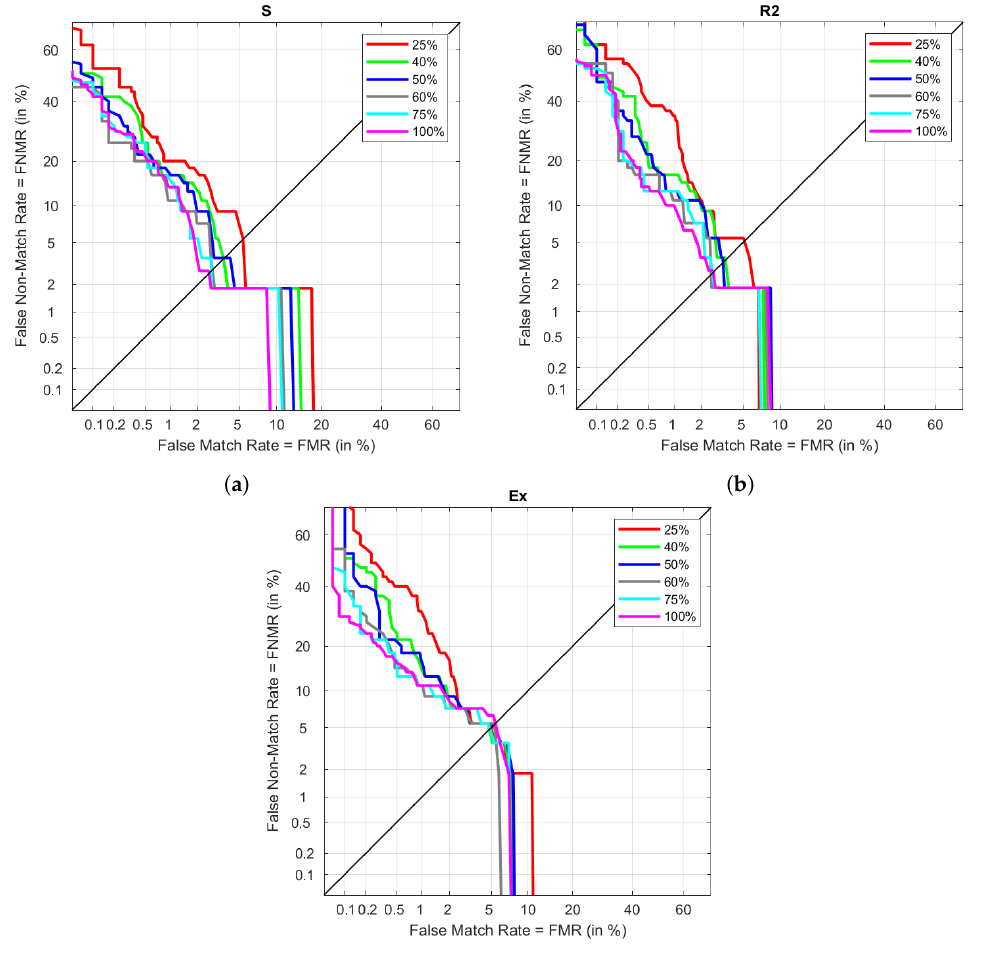
Figure 11. Performance results with different sizes of enrolment for ( a ) S, ( b ) R2, and ( c ) Ex data as test set with the final MLP